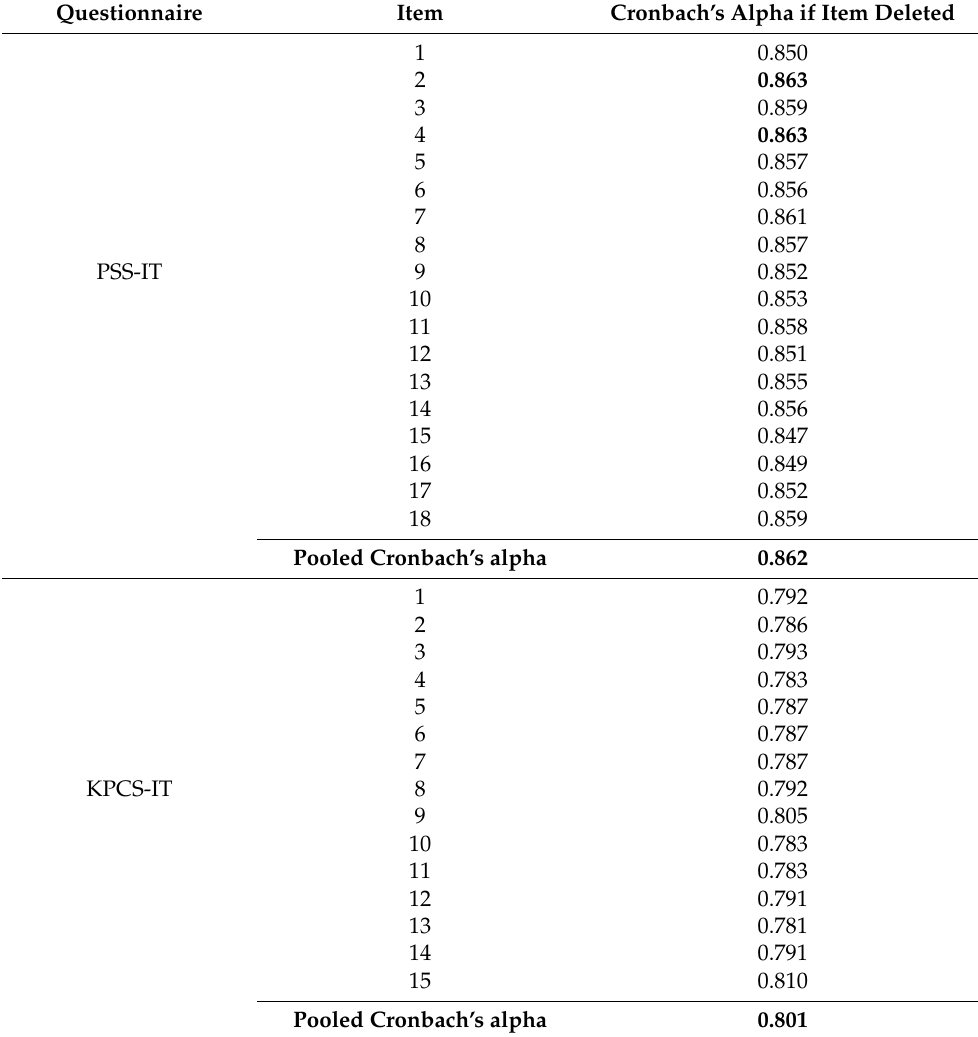
Table 1. Cronbach’s alpha of KPCS-IT, PSS-IT scores.